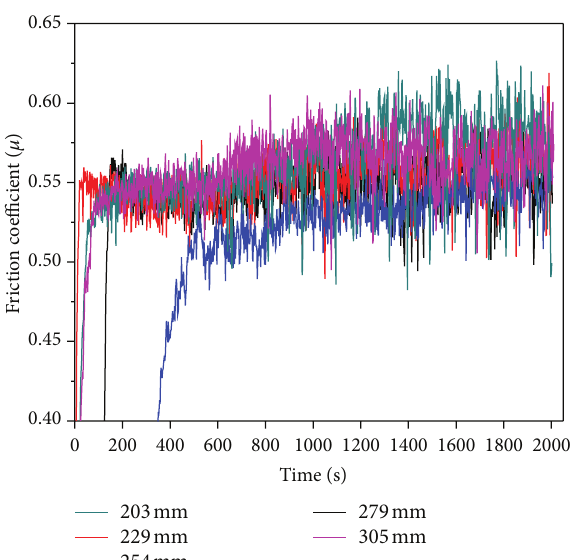
Figure 9: Specimens after the adhesion test.